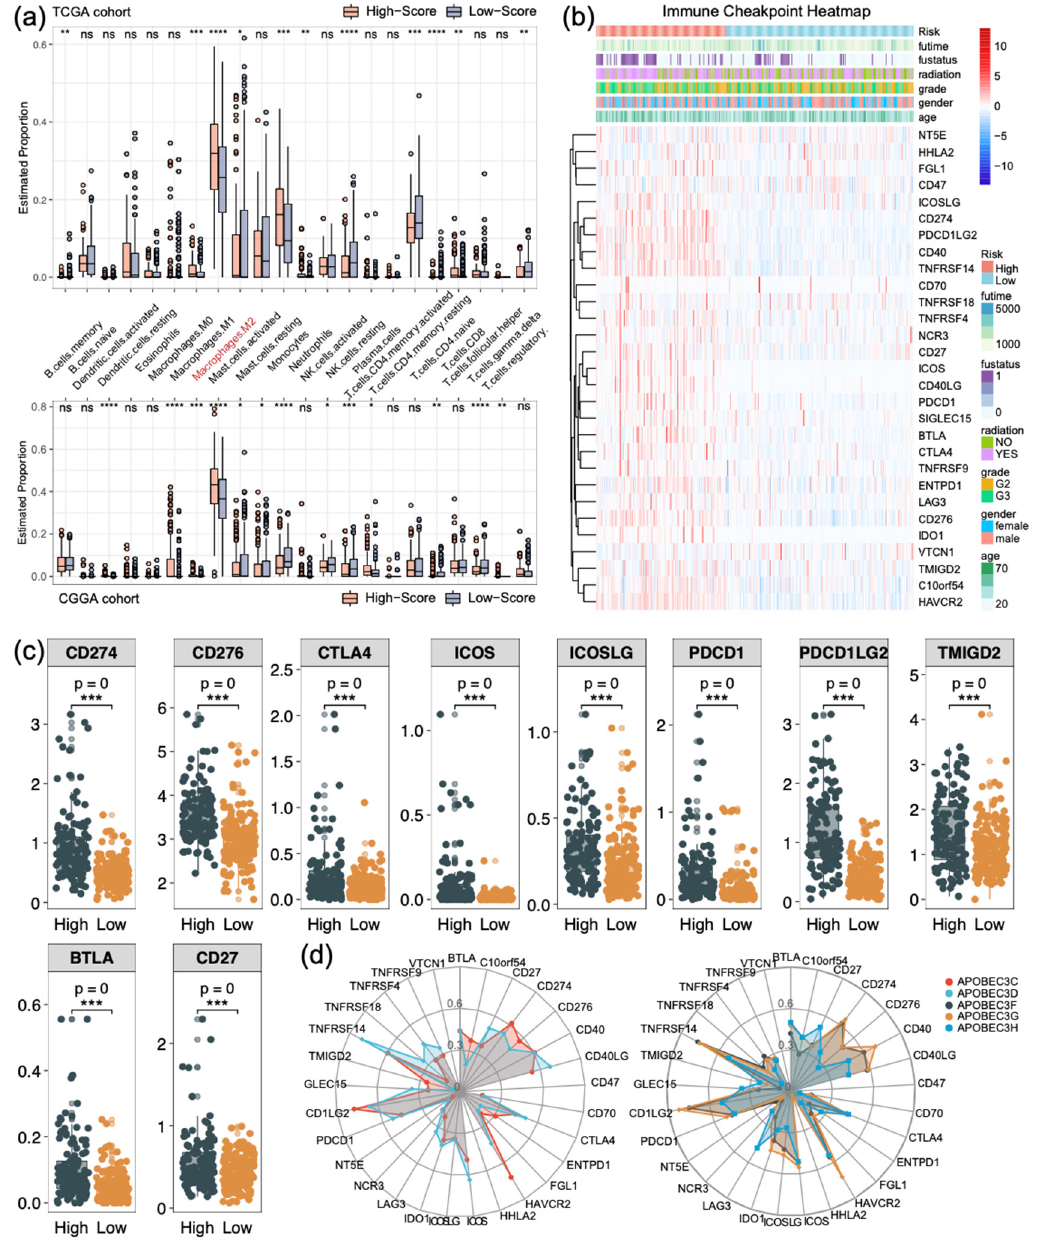
Figure 7. The relationship between different APOBEC3 expression groups and immune profiles in low-grade glioma. ( a ) Boxplot of the CIBERSORT algorithm for evaluating the proportion of 22 kinds of immune cell infiltrations in high- and low-expression solid tumors. ( b ) The heatmap integrated the clinical features and immune checkpoint expression in the TCGA dataset. ( c ) Most immune checkpoints were activated in the high expression group in TCGA glioma patients. ( d ) Radar graph of the APOBEC3 family and immune checkpoint based on correlation coefficient. * p < 0.05, ** p < 0.01, *** p < 0.001, **** p < 0.0001.